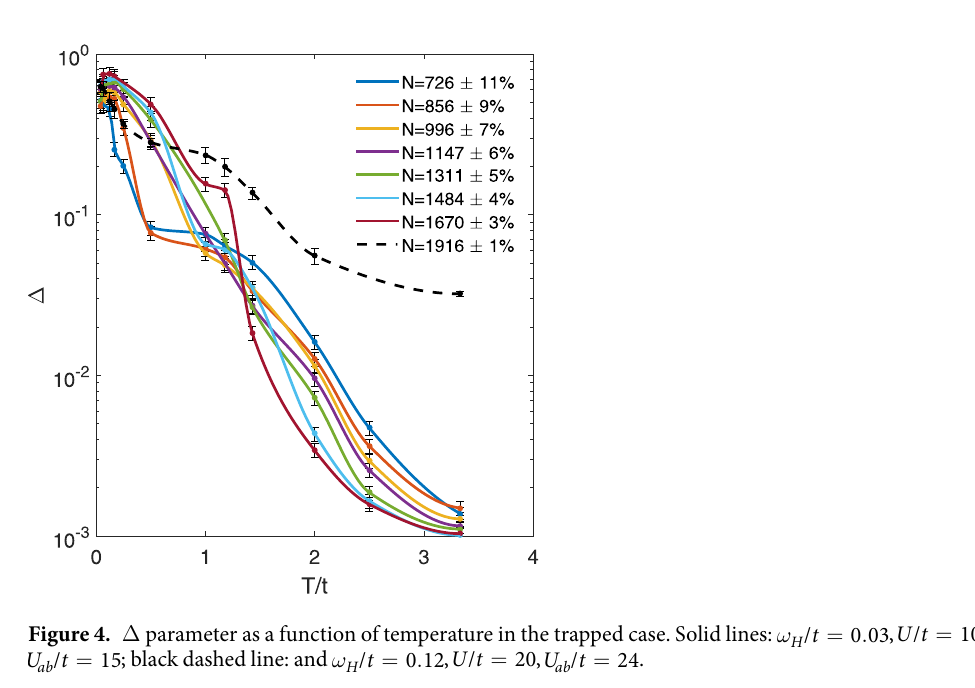
Figure 3. Density maps (first row) of species A (green) and B (blue), and computed momentum distributions of species B (second row) for decreasing temperature (left to right). The mixture ( U / t = 10, U ab / t = 15) is trapped in a harmonic potential of strength ω H / t = 0.03.